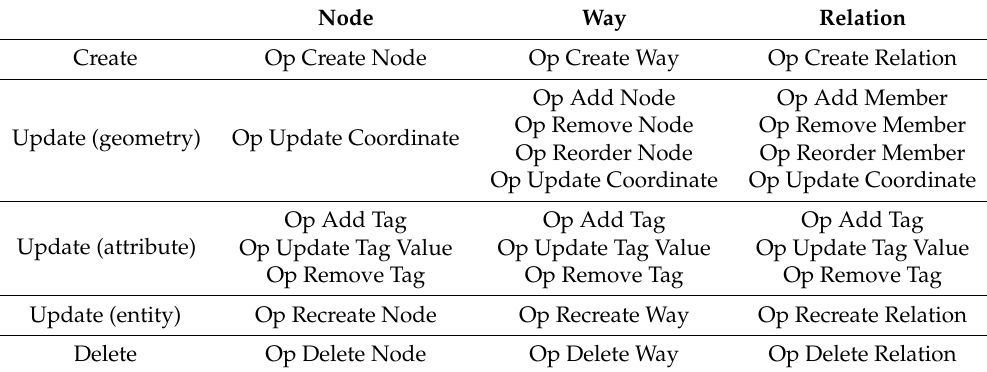
Table 4. Overview of different operation types being executable on the different OSM data types (Node, Way, Relation).